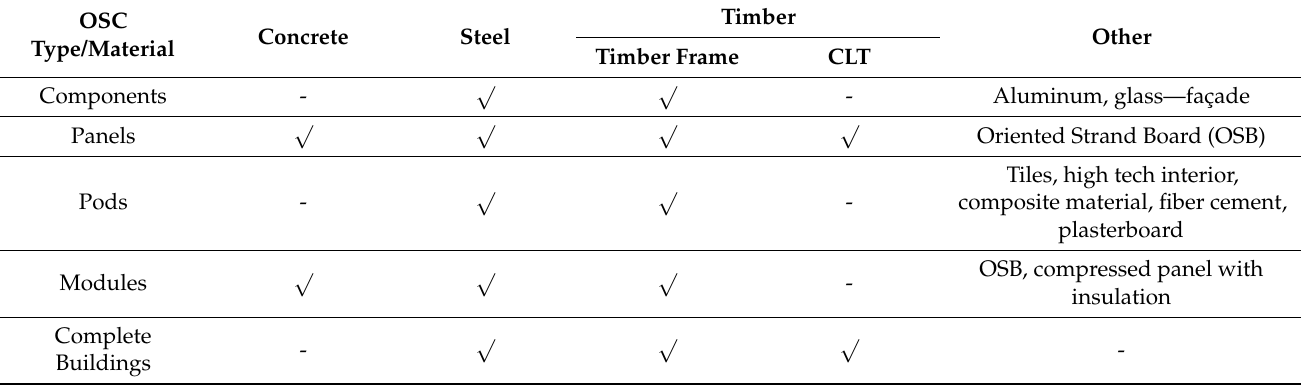
Table 4. Material used for OSC